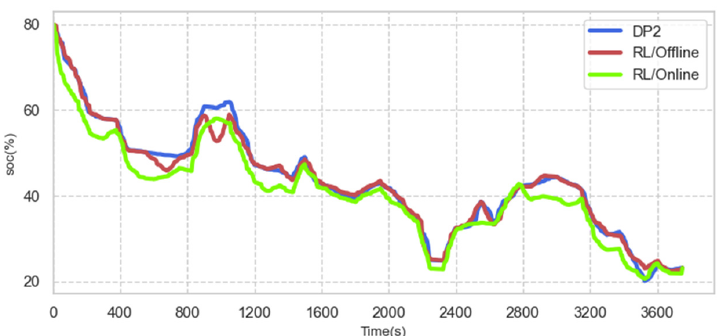
Figure 22. SOC tracking record of long flight mission. Table 6. Comparison of application effects of different control strategies.